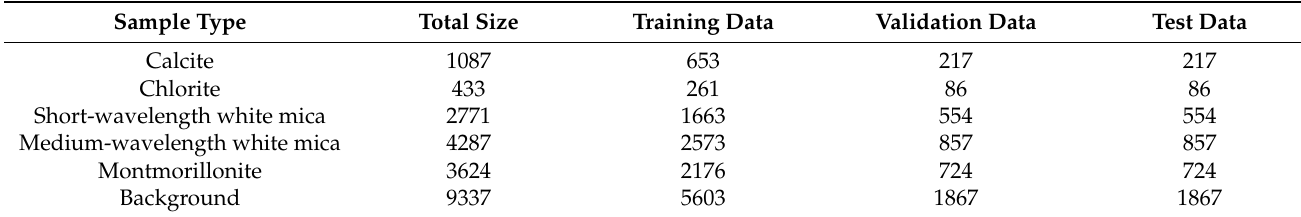
Table 2. Sample dataset of the test area.